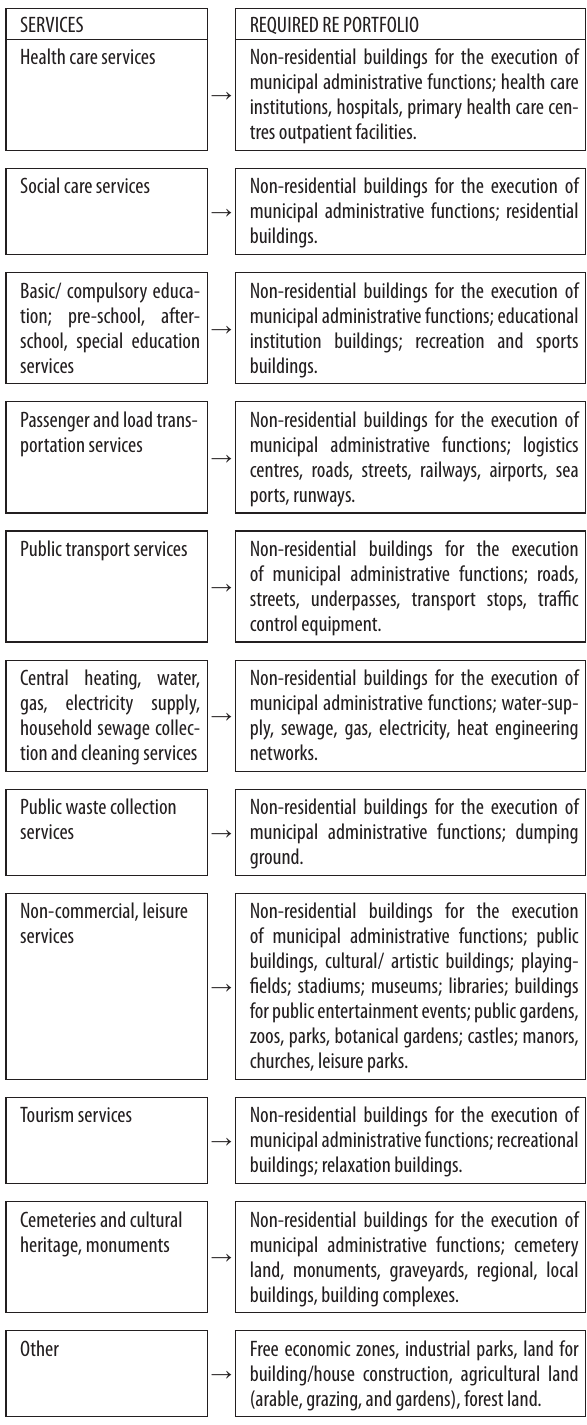
Fig. 1. Services provided by municipalities and required